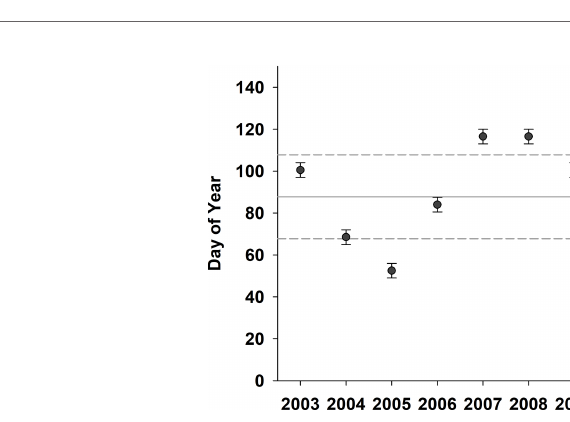
FIGURE 2 | Satellite-derived spring Chl a bloom initiation from 2003-2016 in the Central Strait of Georgia, BC. Black dots indicate the middle of the 8-day week (day of year) with error bars representing +/- 3.5 days. Solid horizontal line is the mean bloom initiation date; dashed lines show the +/- 1 standard deviation used to de fi ne “ early ” vs. “ late ” blooms.